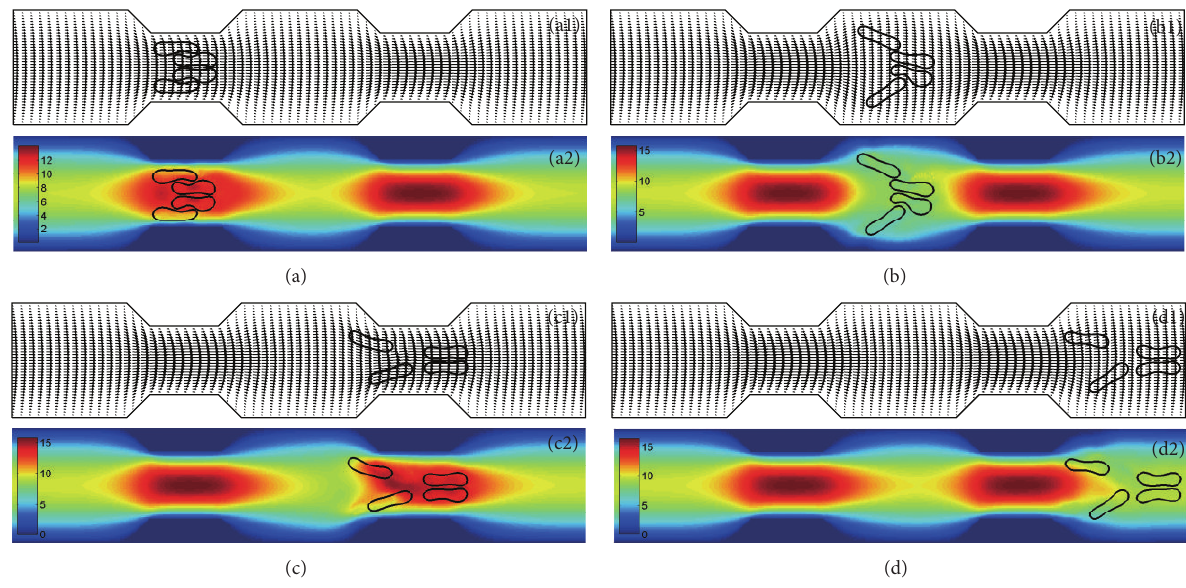
Figure 5: Motion and dissociation of a four-cell erythrocyte aggregate in a 12 𝜇 m stenotic channel at time instants (a) 𝑡 = 0.33 ms; (b) 𝑡 = 0.55 ms; (c) 𝑡 = 0.75 ms; and (d) 𝑡 = 0.93 ms. Velocity vectors (a1-d1) and axial velocity magnitude contours (cm/s) (a2-d2) are presented. The initial configuration for the aggregate is shown in Figure 1(e), and the aggregate is horizontally placed in the channel initially. The parameters used are 𝐷 𝑒 = 1.0 × 10 −2 𝜇 J/m 2 , 𝑘 𝑏 = 3.0 × 10 −12 Nm.